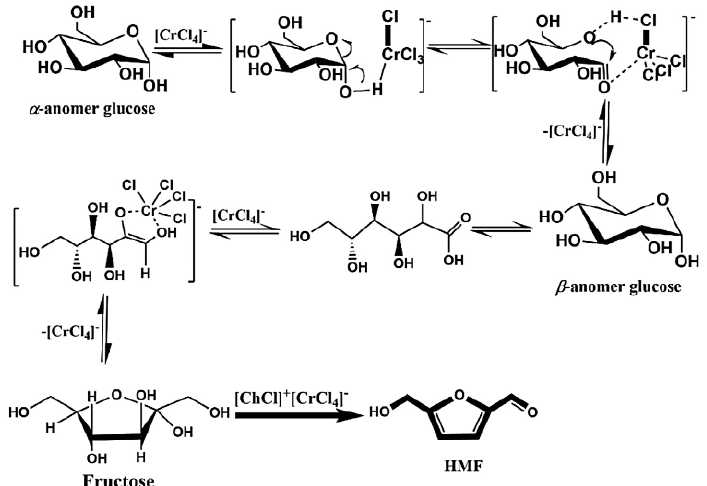
Figure 11. The proposed mechanism pathway for dehydration of glucose to 5-HMF. Reprinted from reference [75] with permission.